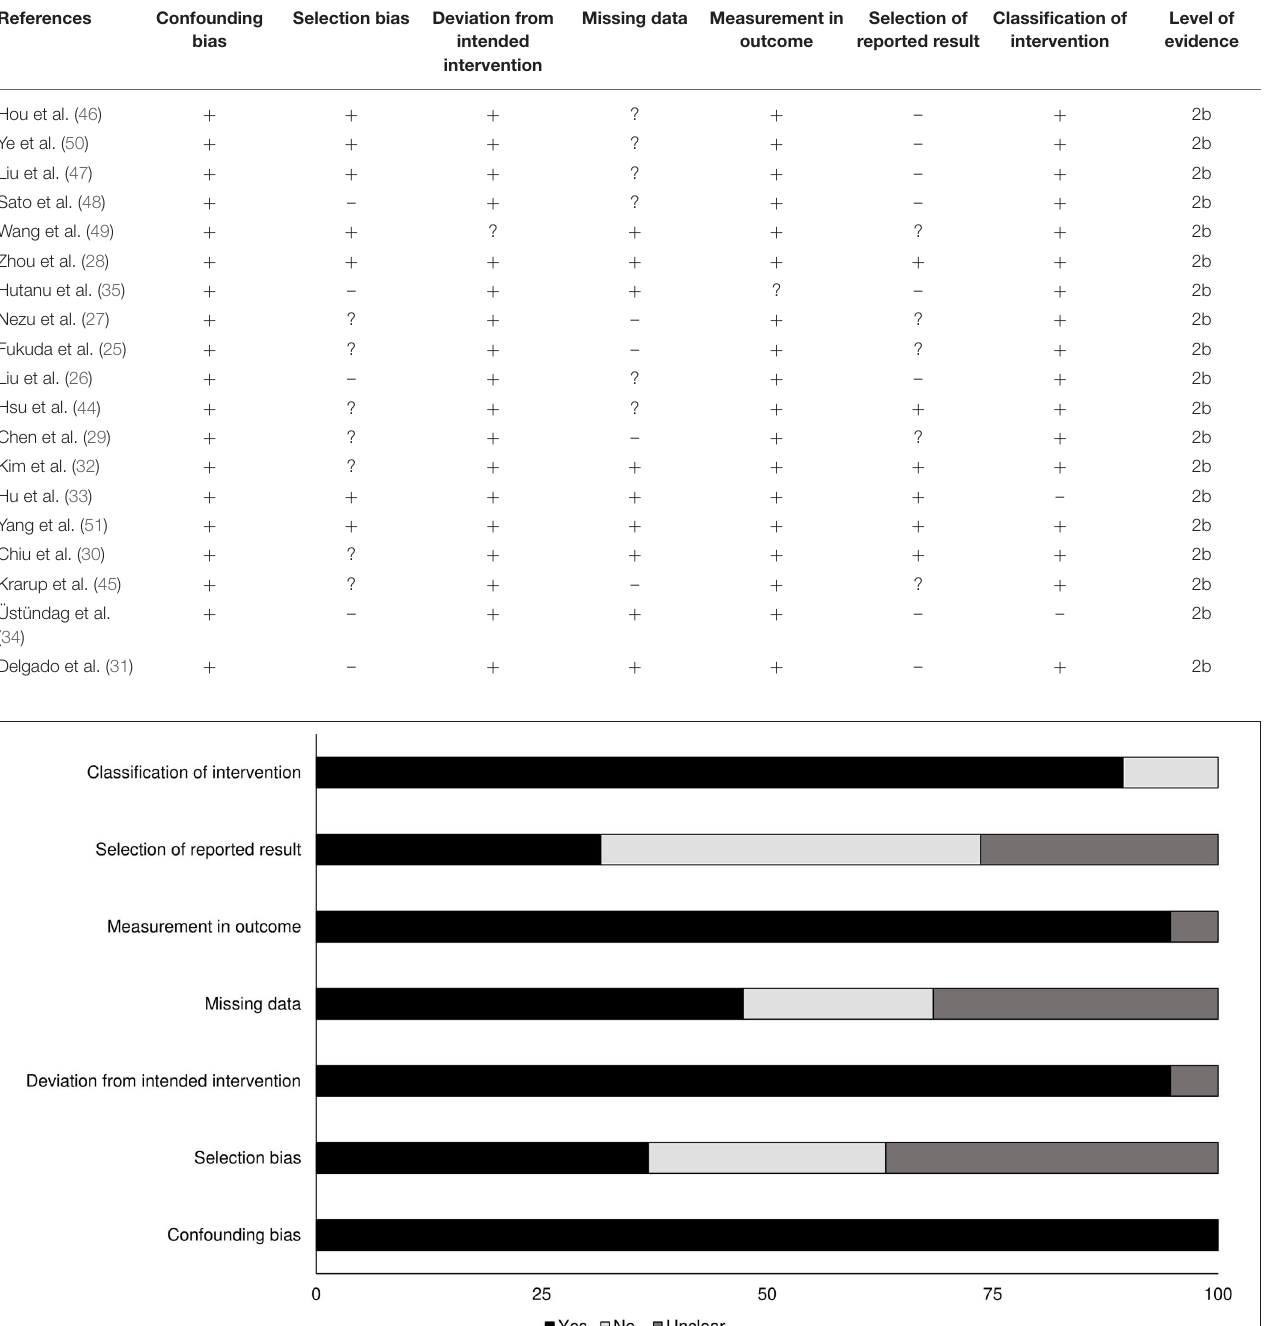
TABLE 2 | Risk of bias according to Cochrane’s risk of bias assessment tool for included non-randomized controlled trials.